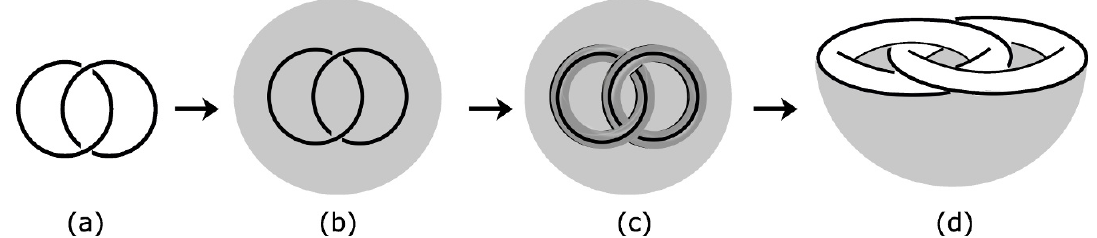
Figure 3 . Figure (a) shows the Hopf link which is embedded into S 3 in (cid:12)gure (b). The Hopf link is (cid:12)rst thickened into a tubular neighbourhood in (cid:12)gure (c) and then removed from S 3 . The resulting manifold S 3 n H is called the Hopf link complement as shown in (cid:12)gure (d) whose boundary consists of two linked tori T 2 [ T 2 . The Chern-Simons path integral gives a quantum state on this boundary whose entanglement structure can be